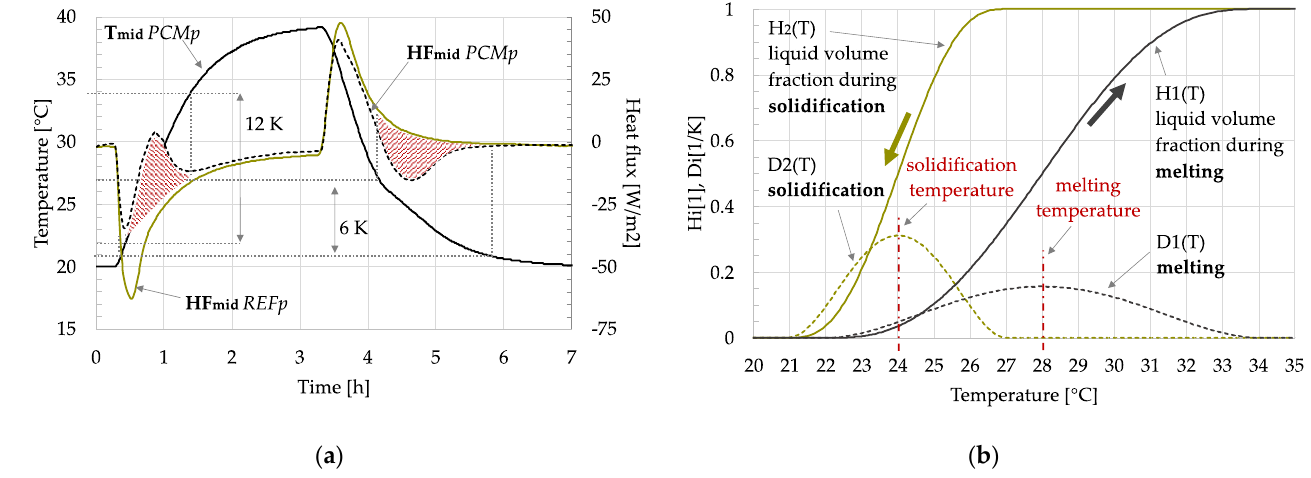
Figure 5. ( a ) Melting and solidification temperature individuation and relative ranges through the comparison of the heat fluxes (HF mid ) of REFp and PCMp . Colored areas indicate the phase change of the PCM ( b ) H i ( T ) and D i ( T ) functions implemented in COMSOL Multiphysics. The arrows indicate the direction of the curve.